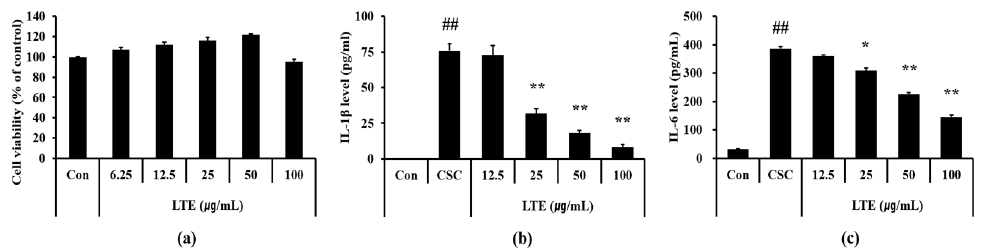
Figure 5. Effects of LTE on the production of inflammatory cytokines in CSC stimulated H292 cells. ( a ) cell viability, ( b ) IL-1 β level, and ( c ) IL-6 level. This experiment was performed in triplicate. Data shown as the mean ± SD. ## , vs. Control, p < 0.01, *, **, vs. CSC stimulated cells, p < 0.05 and <0.01, respectively.